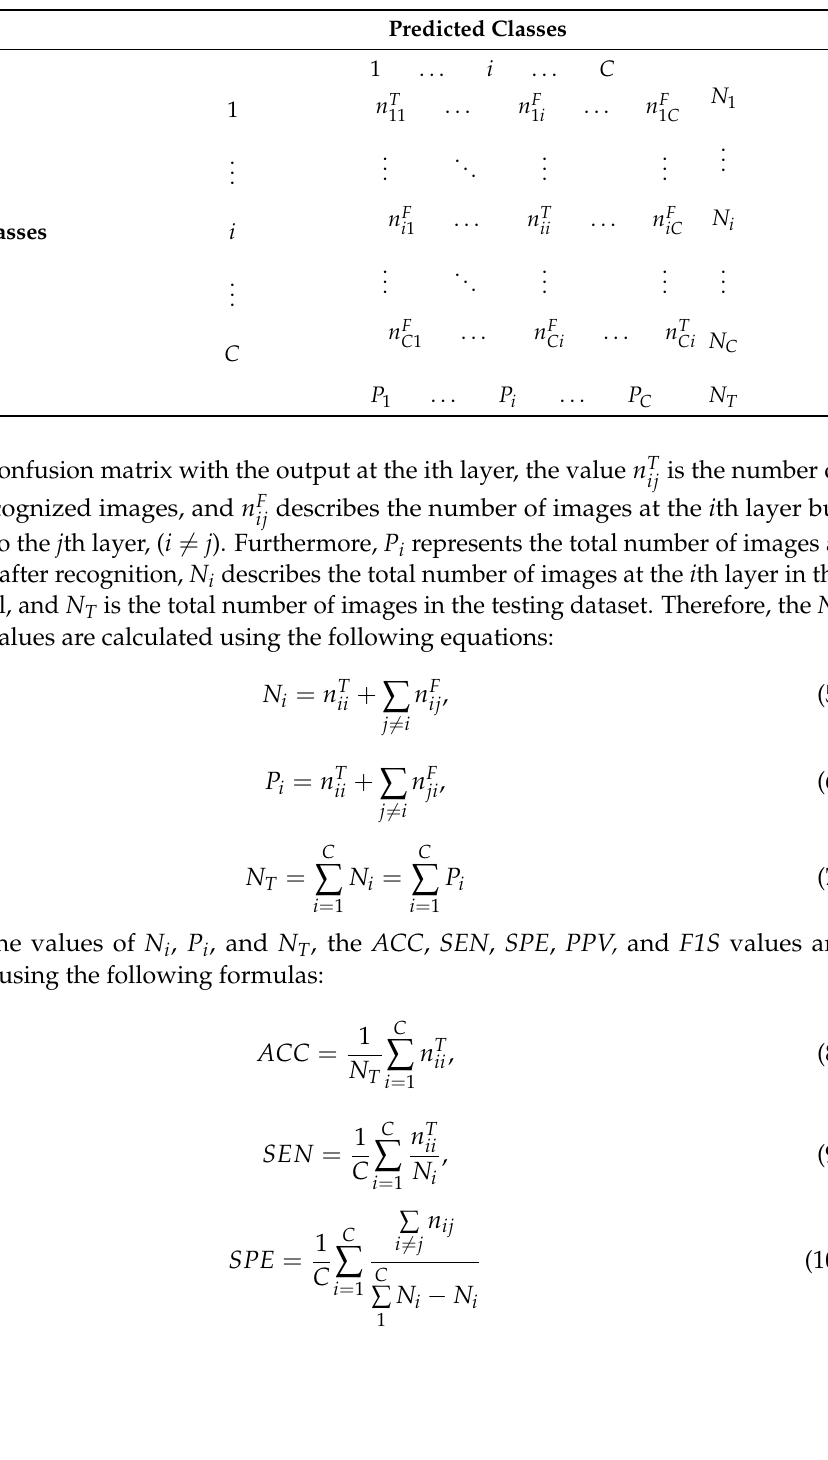
Table 2. Representation of the confusion matrix with many layers [51].